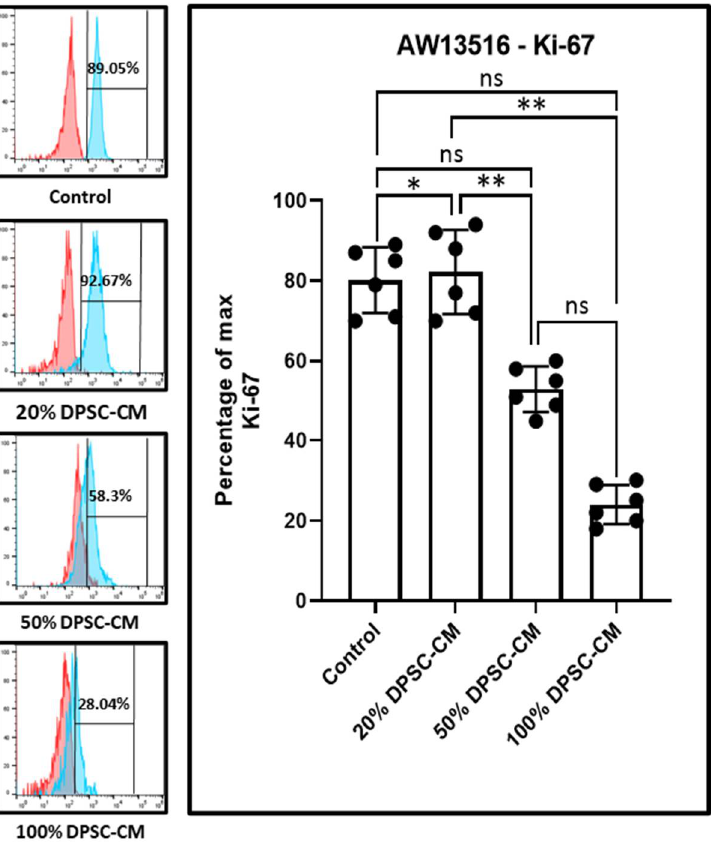
Figure 4. Dose-dependent effect of the DPMSC-CM ( n = 3) on the Ki-67 status of AW13516 at 48 h. * p < 0.05, ** p < 0.01, ns not significant. DPSC-CM: Dental pulp stem cell-conditioned medium, Ki-67: Marker of proliferation Ki-67.